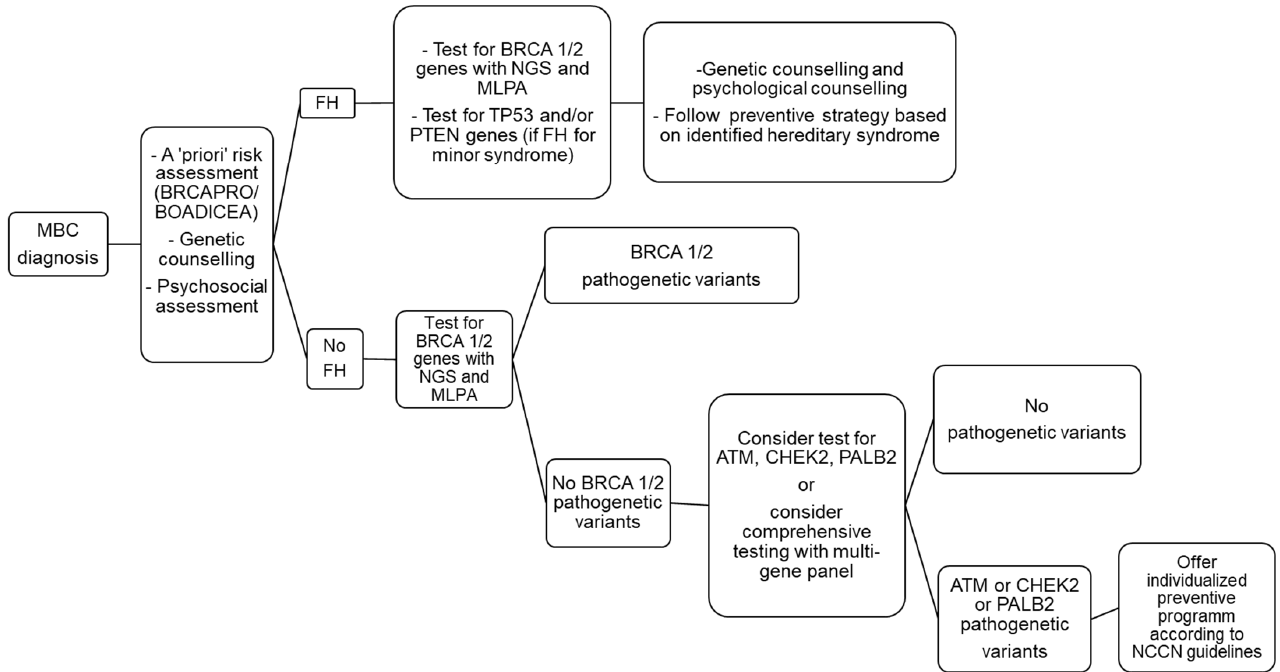
Figure 1. Genetic testing flow chart after a diagnosis of breast cancer (BC) in a male